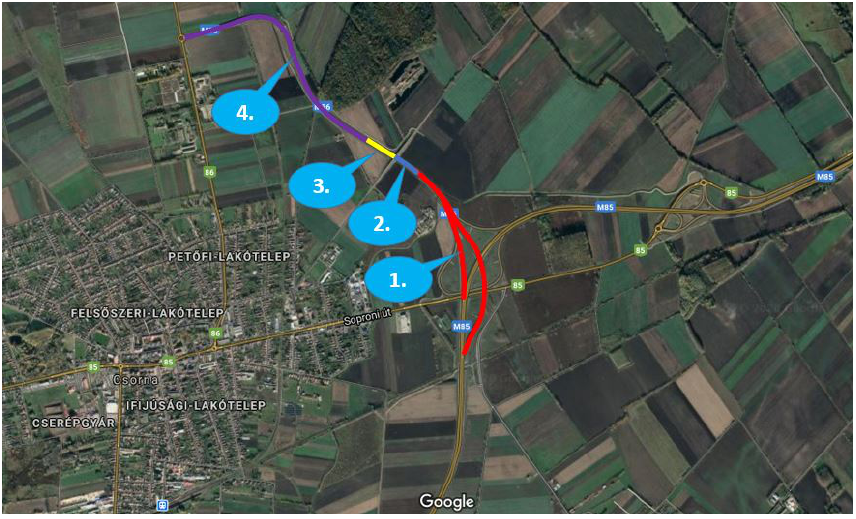
Figure 2. Sections of the test site (3.5 km in all) located near Csorna city (Hungary) on route E65 (GNSS coordinates: 47.625778,